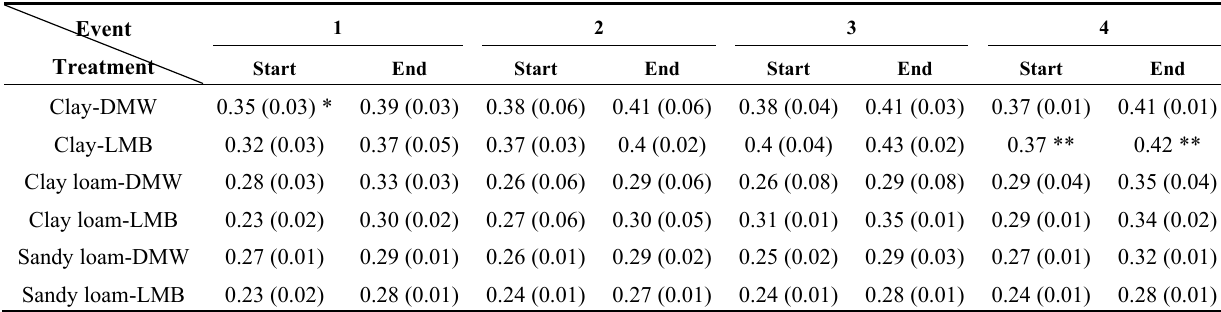
Table 3. Average volumetric water content ( θ ) of lysimeter